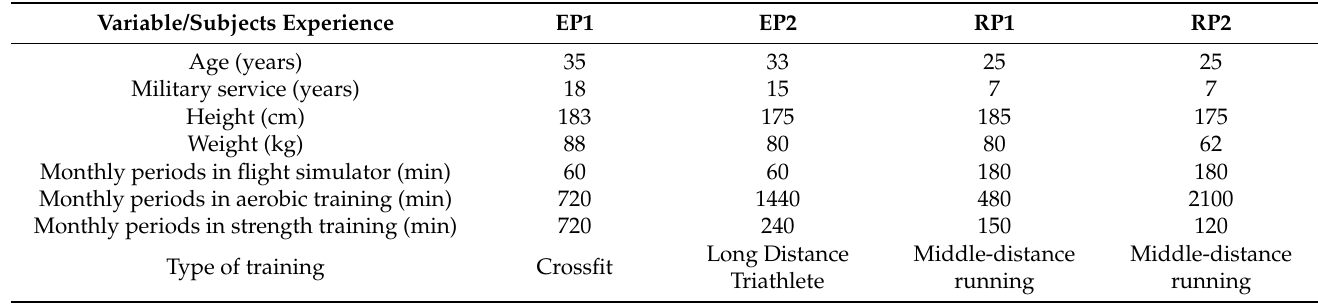
Table 1. Characteristics of military